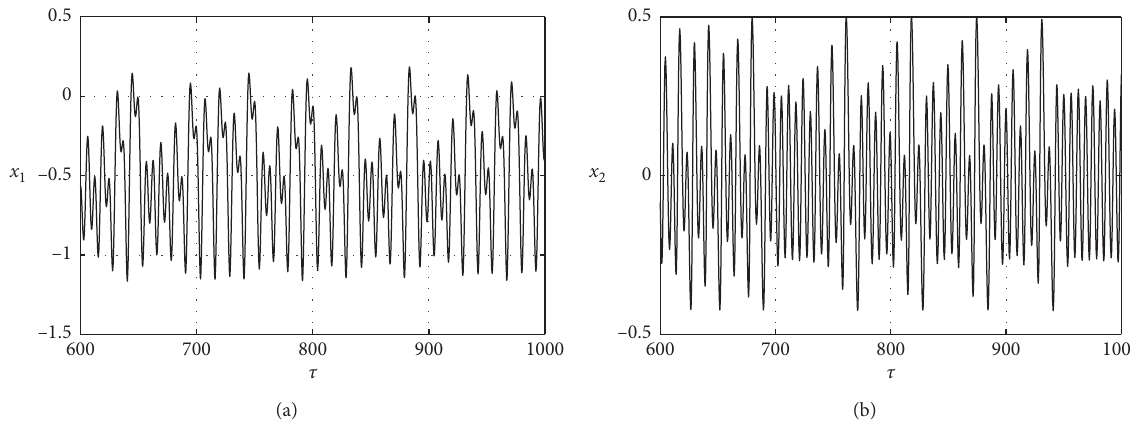
Figure 5: (a) Time history of displacement x � 0.1, a � 1.6, b � 0.05, c � 0.35, d � 4 / 27, e � 0.0001, 1 and (b) time history of velocity x 2 with r Γ � 0.2, p � 0.009, Ω � 1.0, and β � 0.01818.